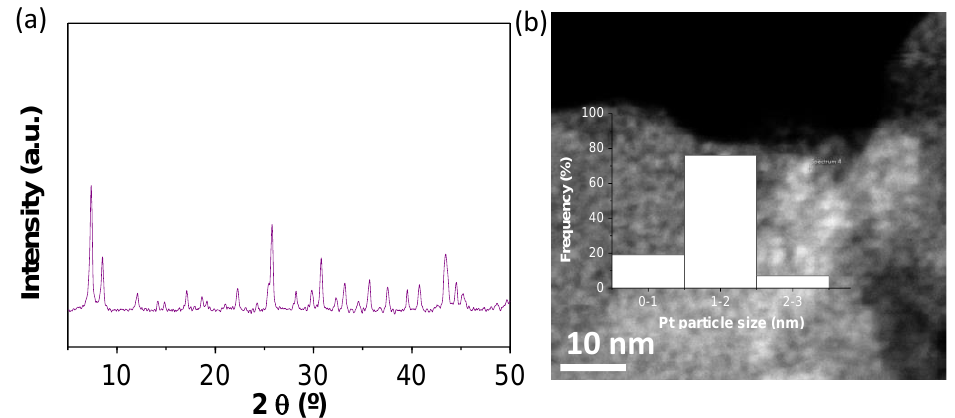
Figure 7. XRD ( a ) and representative DF-STEM image and platinum particle size distribution ( b ) of fresh Pt@UiO-66(Zr)-NH 2 .